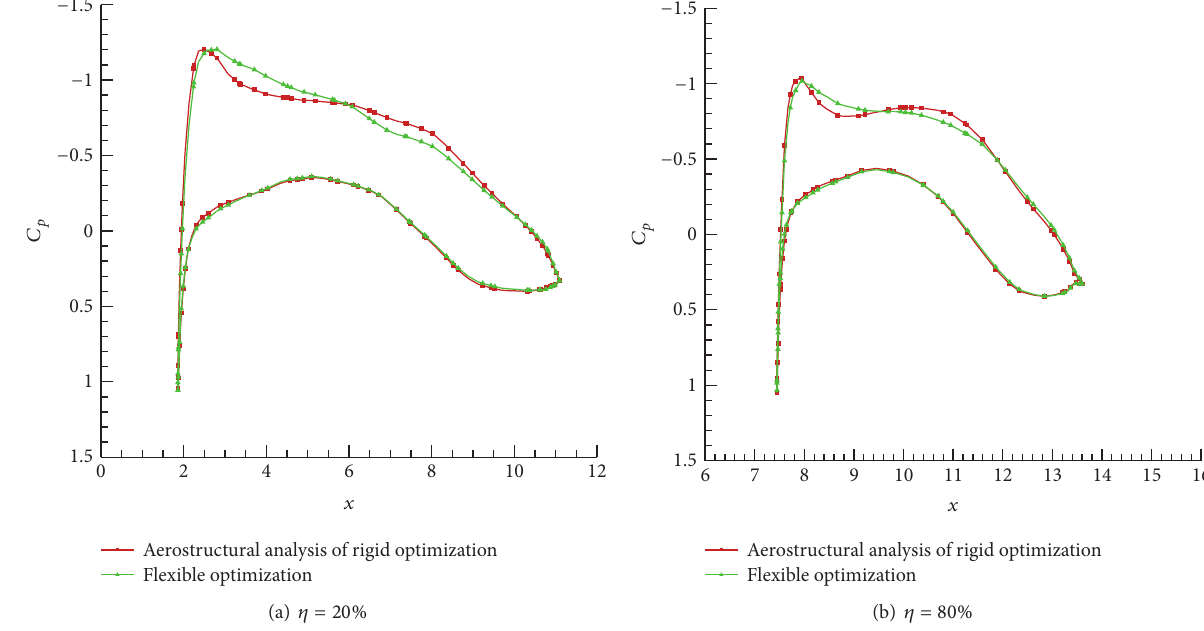
Figure 18: Comparison of section pressure distributions of aerostructural analysis of rigid optimization and flexible optimization.